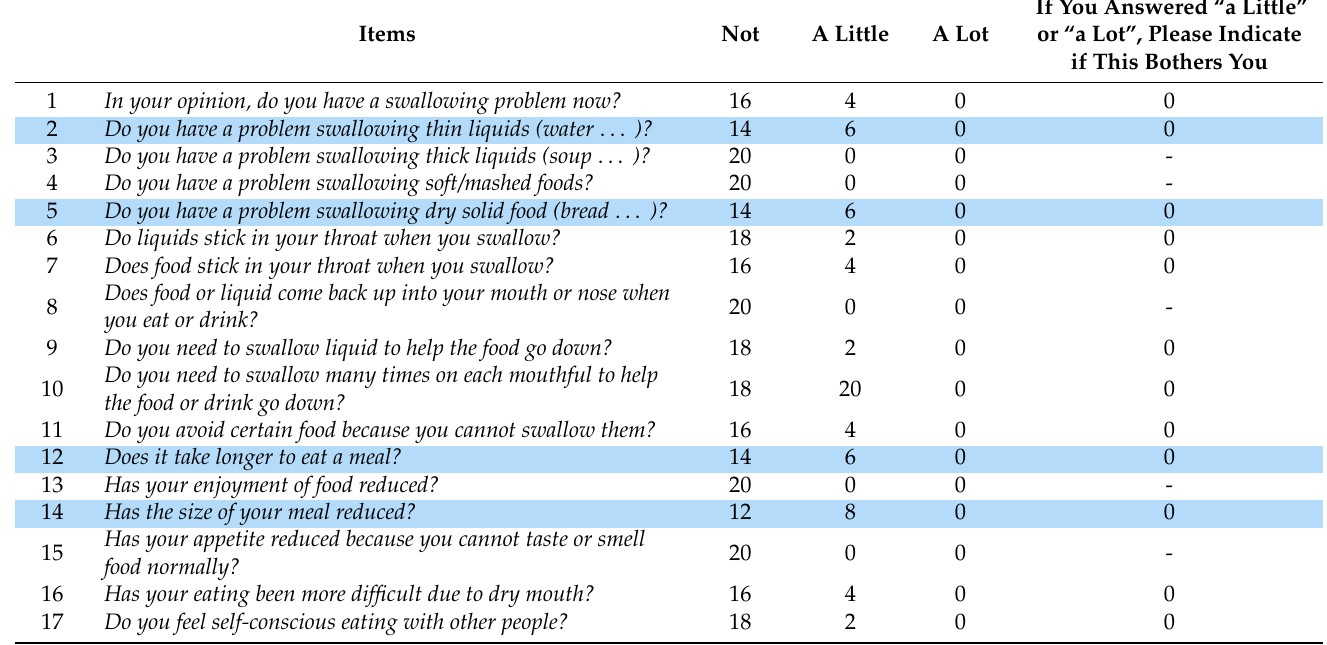
Table 3. Swallowing outcome after laryngectomy (SOAL) questionnaire [16] (one year after surgery).